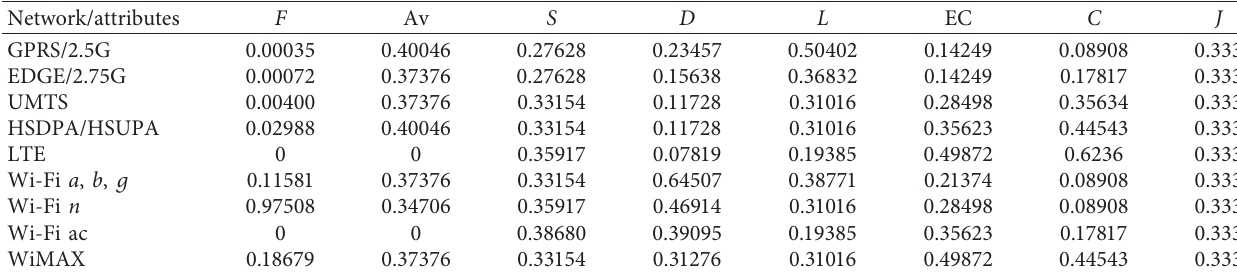
Table 6: The normalized R matrix.